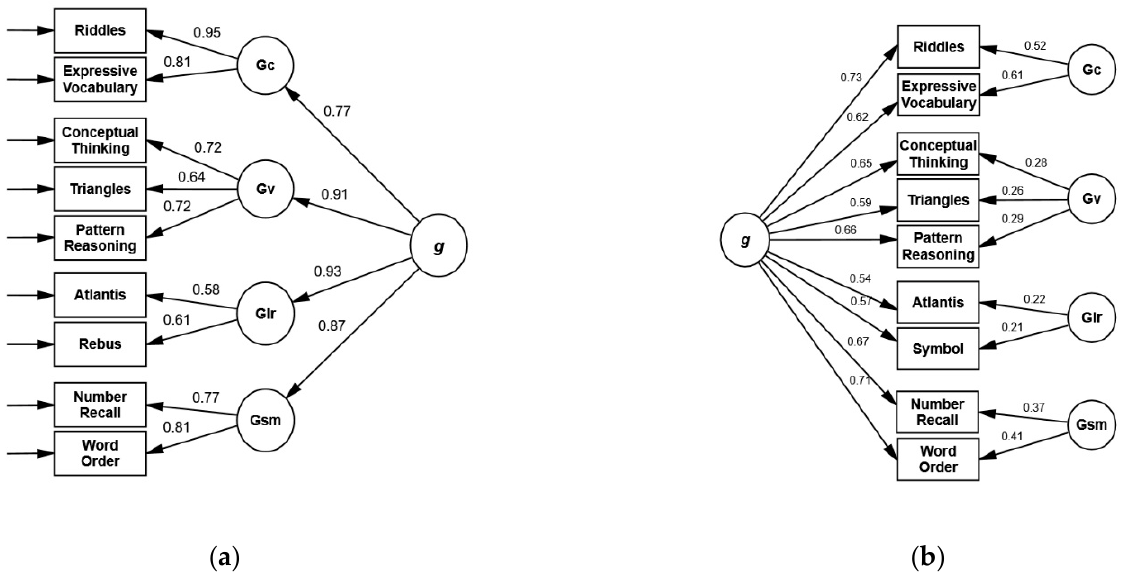
Figure 1. Second-order model 2b ( a ) and bifactor model 3b ( b ) with standardized loading coefficients for the KABC-II CHC subtest configuration at age 5. ( a ) χ 2 = 38.26, df = 23, p = 0.024, CFI = 0.983, RMSEA = 0.052, SRMR = 0.033. ( b ) χ 2 = 38.64, df = 23, p = 0.022, CFI = 0.983, RMSEA = 0.052, SRMR = 0.033.